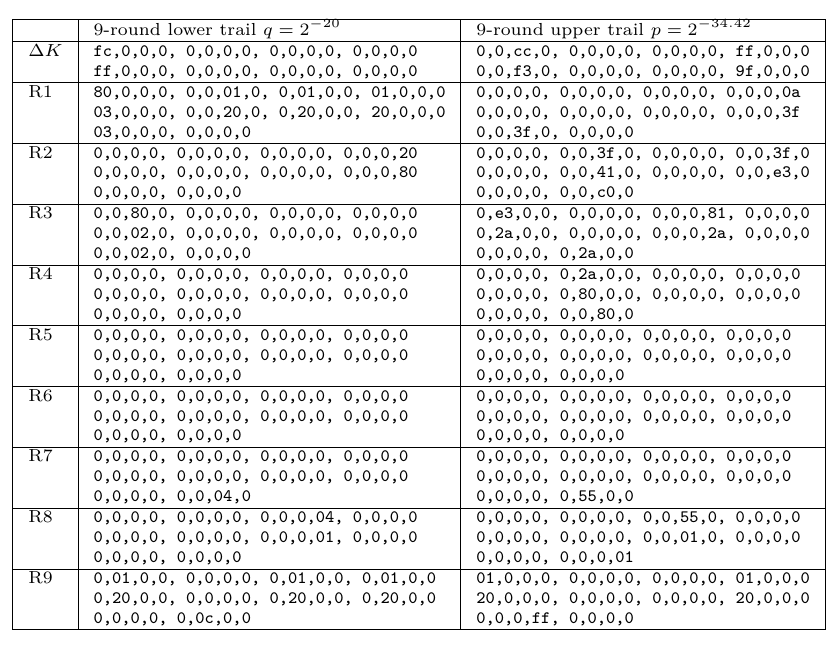
Table 13: Trails for SKINNY-128-256